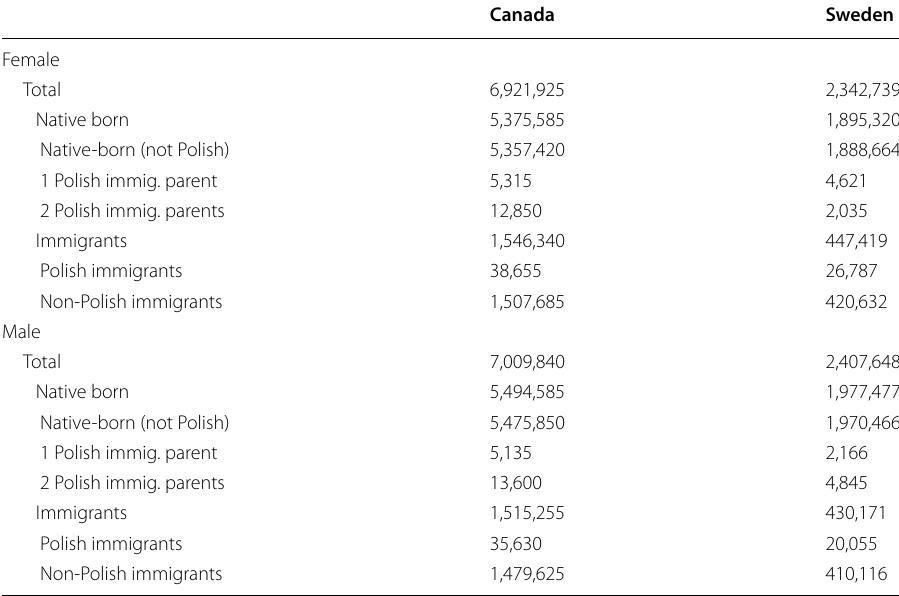
Source: 2016 Census of Canada and 2015 Swedish